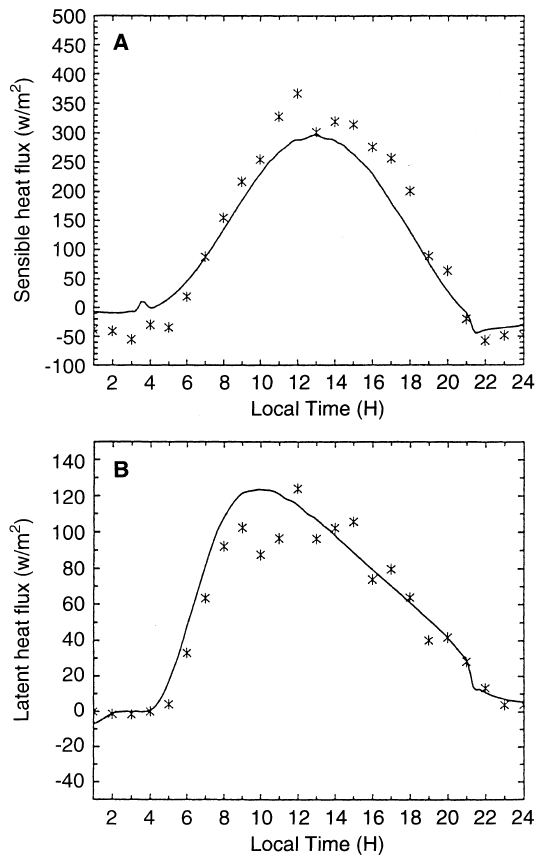
Fig. 11A,B. Time evolution of the computed and measured values of the sensible heat flux A and the B latent heat flux on July 12 from 0000 LST to 2400 LST. The stars correspond to observations at site 4